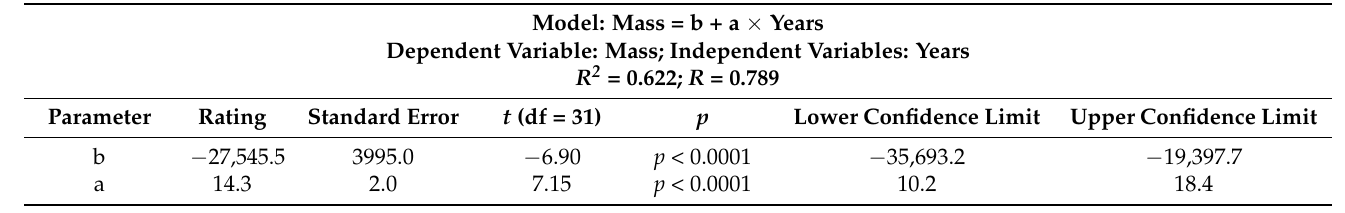
Figure 3. The average weight of a passenger car (including standard error and standard deviation) in relation to the year of production. Table 4. Results of regression analysis of the linear function for the whole vehicle mass.